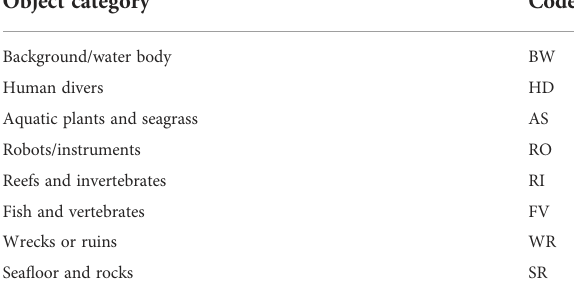
TABLE 4 Classes of objects annotated with pixels in the dataset and the corresponding codes. Object